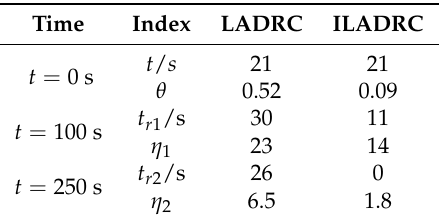
Table 2. Control performance